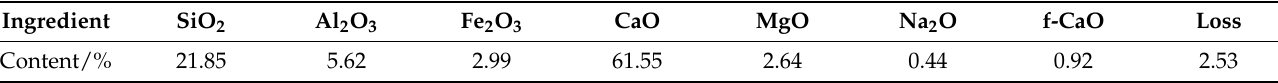
Table 1. Chemical composition of